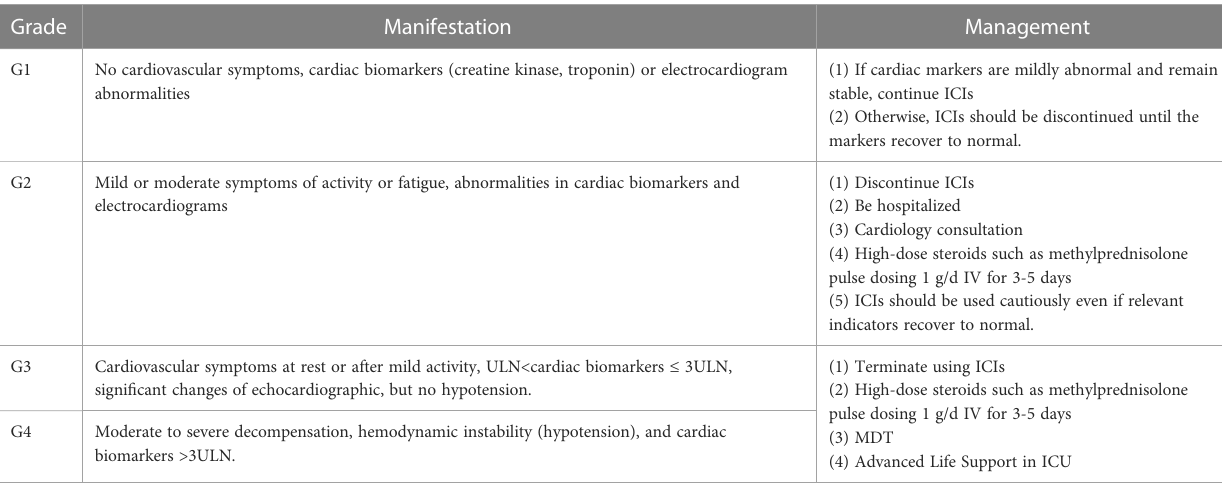
TABLE 1 Grading, manifestation, and management of